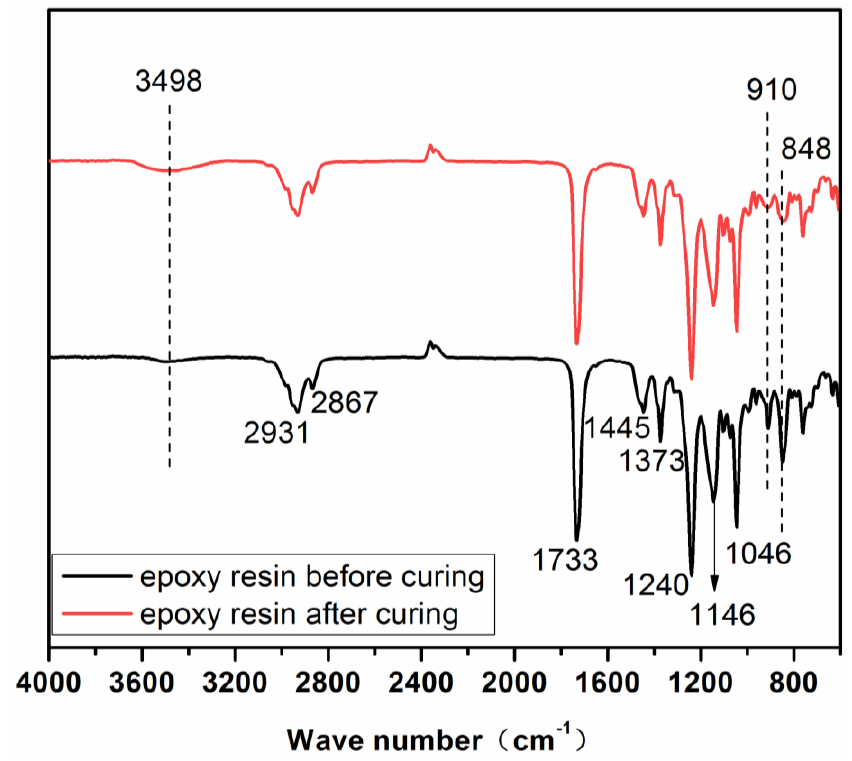
Figure 1. FTIR spectra of rosin − based epoxy resin before and after curing.